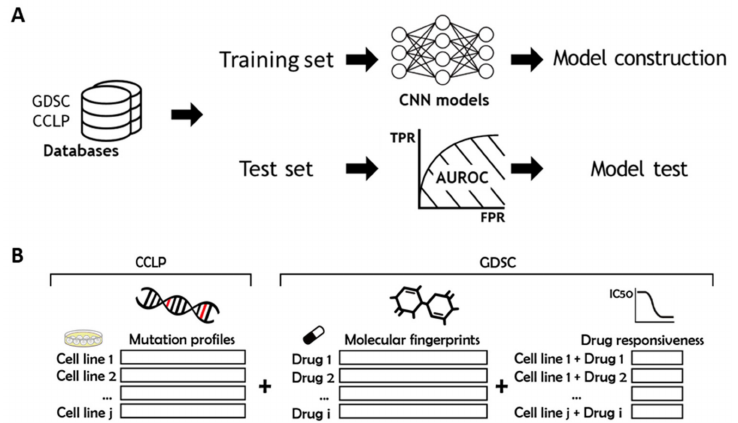
Figure 1. Overview of scheme. ( A ) To build and train two CNN models, and the LASSO baseline model, pharmacogenomics data from CCLP [35] and GDSC [34] were used. Independent GC cell line data from CCLLE [33] were used to test the performance of the three models in predicting drug responsiveness. The performance of the three models was compared by AUROCs. ( B ) Mutation profiles data for cancer cell lines were obtained from CCLP. Molecular fingerprints data for drugs and responsiveness data for ‘cancer cell lines and drugs’ were obtained from GDSC. The model was trained to predict drug responsiveness by calculating mutation profiles data and molecular fingerprints data as